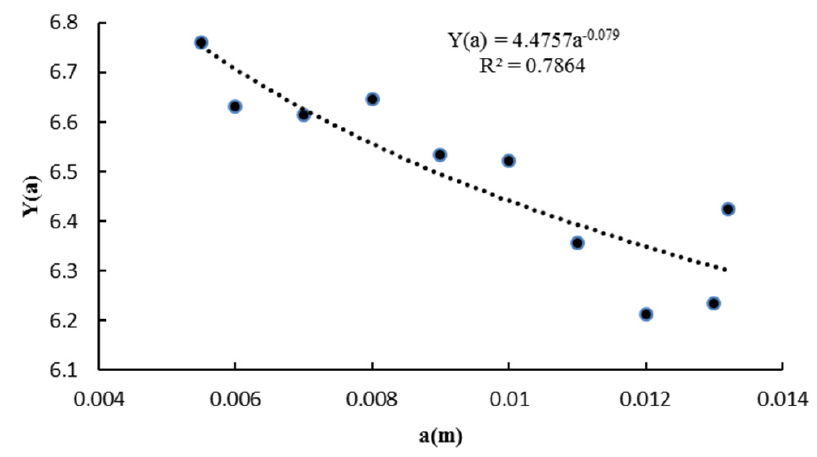
Figure A1. Geometry function and fitted power function for sensitivity study.